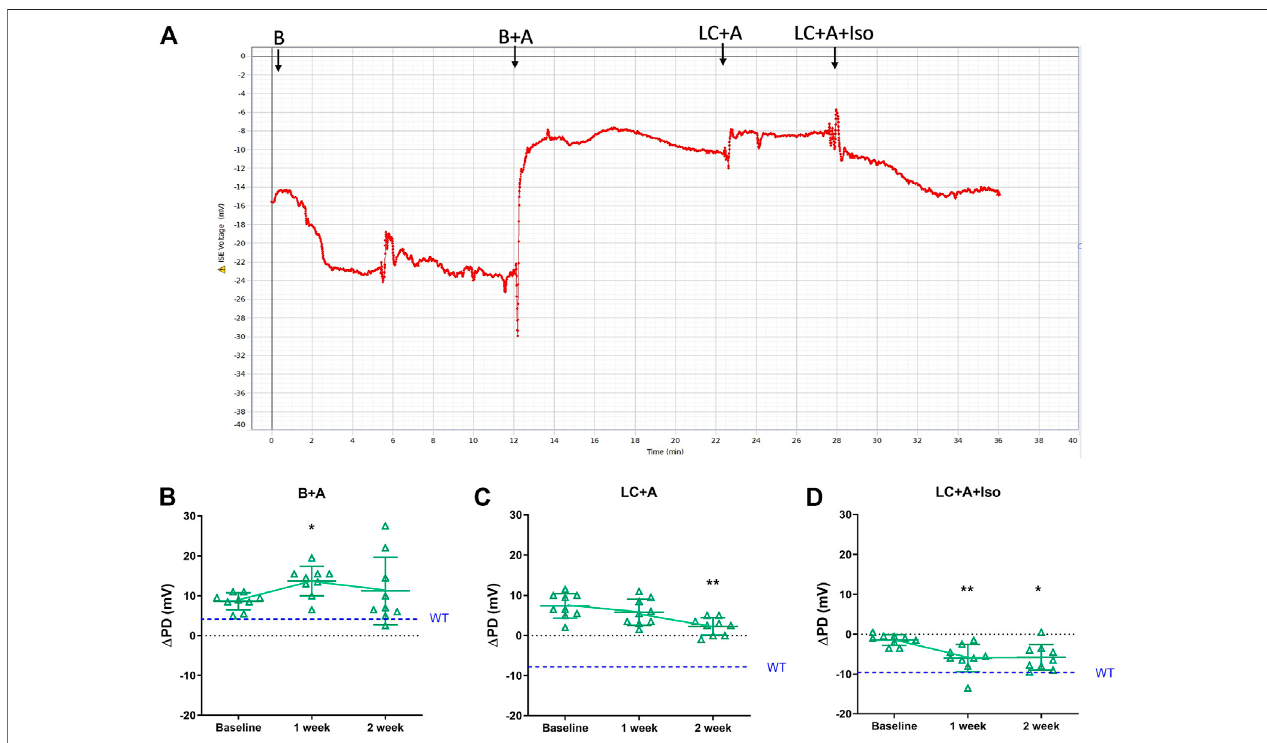
FIGURE4|(A) NasalPDtraceofaCFTRtreatedCFmousefollowinginfusionofKRBbasal(B),basal+amiloride(B+A),Lowchloride+amiloride(LC+A)andLow chloride + amiloride + isoproterenol (LC + A + Iso). Δ PD in CF mice before (Baseline), 1 and 2 weeks after second generation LV- CFTR gene addition to nasal airways following (B) Basal + Amiloride (B + A), (C) Low chloride under amiloride (LC + A) and (D) LC + A and isoproterenol (Iso) in KRB at the 20 μ l/min infusion rate (* p < 0.05, ** p < 0.01, Mean ± SD, Dunnett ’ s RM ANOVA vs Baseline, n (cid:2) 9). The Δ PD wildtype level (WT) designated by dashed blue line.